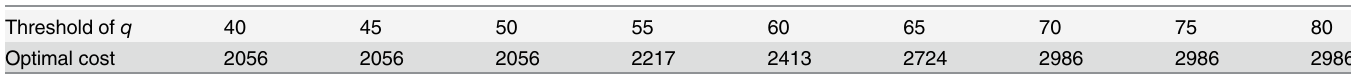
We then consider all β = 0.001 (that is, the stochastic demand of every retailer can be ffiffiffiffiffiffiffiffiffiffiffiffiffiffiffiffiffiffi p i 2 ln ð 1 = b Þ ¼ 3 : 72 is obtained. guaranteed with the probability 1 − β = 99.999%), and O ¼ Solving model (21) with the above data using LINGO solver, we find that the optimal ordering strategies for the three retailers are 22, 21.34, and 20, respectively, and the optimal cost value is 2700, in which the free shipping condition is satisfied for the total order amount of 63.34. By solving model (22) with the above data, we find that the optimal ordering strategies for the three retailers are 22.93, 20.42, and 16.97, respectively, and the optimal cost value is 2413, in which the free shipping condition is satisfied for the total order amount of 60.3. The solution for model (22) is obviously superior to that for model (21); this finding illustrates that the anal- ysis in section 3.3 based on the norm uncertainty set and W is more accurate. Regarding this same numerical experiment, the solution is far superior to that used in [8], in which the optimal value was 2770. Therefore, compared with the linear decision method, the robust analysis in this paper is more scientific because the counter-constraint by the linear de- cision method is linear in [8]. However, the robust counterparts of this paper ’ s model are conic quadratic constraints with a higher degree of complexity. Furthermore, for the more accurate model (22), we consider the sensitivity of the effect of threshold q on the optimal value. Initially, we use the value five times the current value (i.e.,